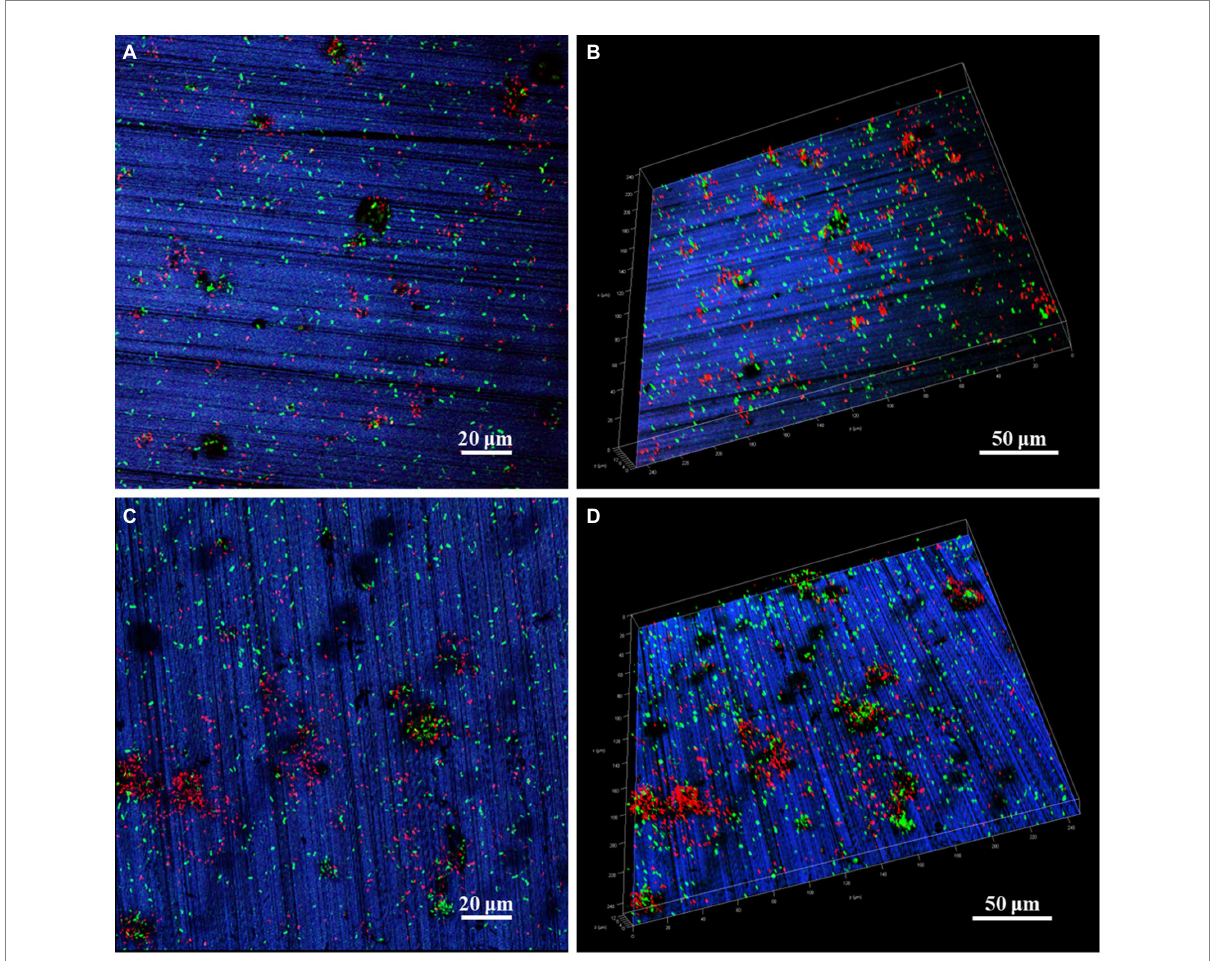
FIGURE 2 CLSM images of P. aeruginosa biofilm on HEA coupon surfaces after (A,B) 7 days and (C,D) 14 days.